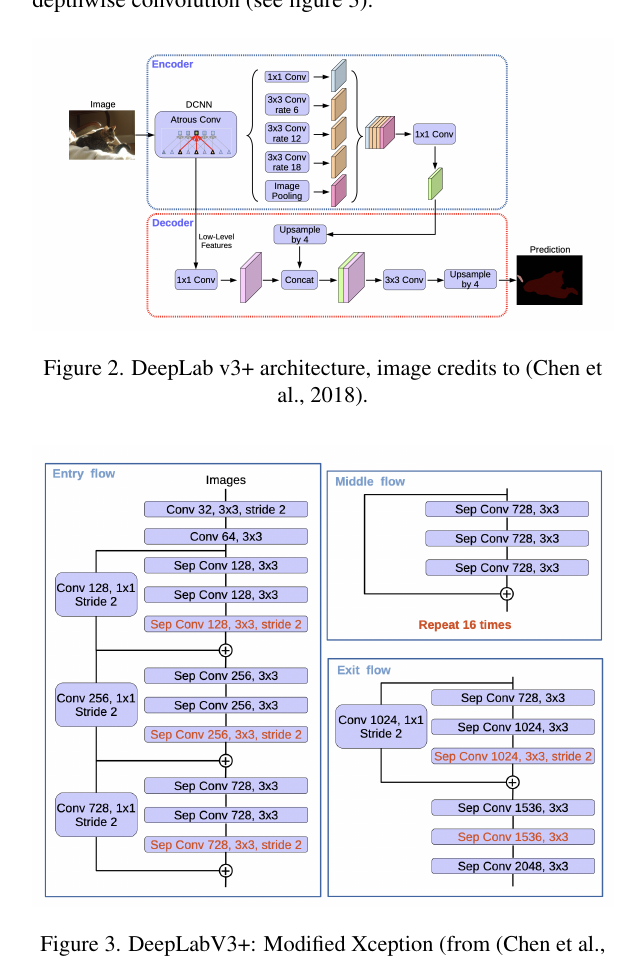
Figure 3. DeepLabV3+: Modified Xception (from (Chen et al.,